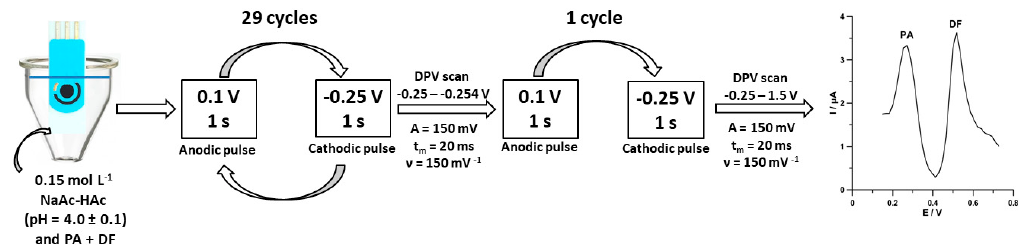
Figure 1. Scheme of voltammetric measurements of paracetamol (PA) and diclofenac (DF) at the SPCE/MWCNTs-COOH.